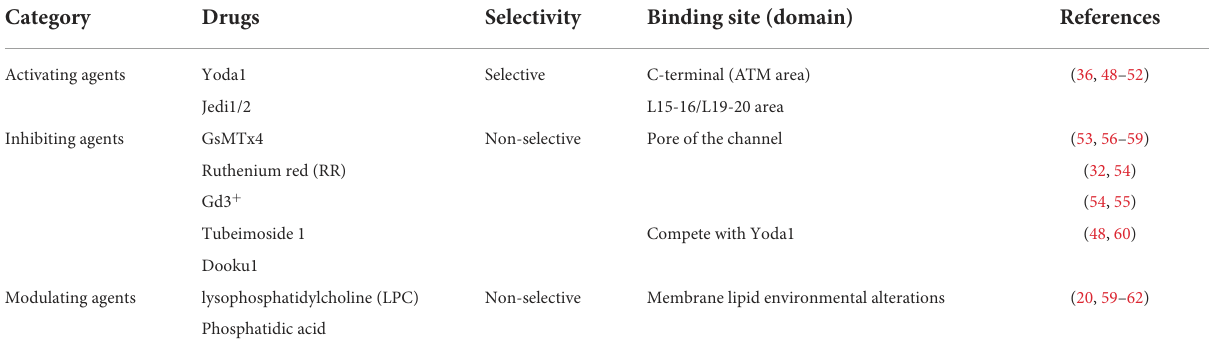
TABLE 1 Summarization of current Piezo1